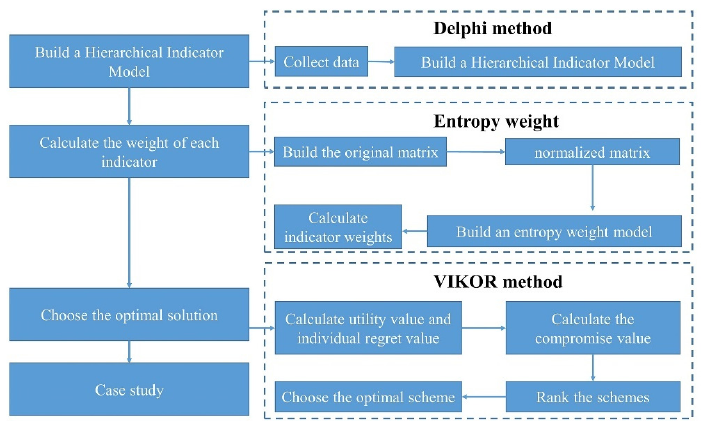
Figure 1. Design scheme evaluation and optimization process based on entropy weight and VIKOR method.